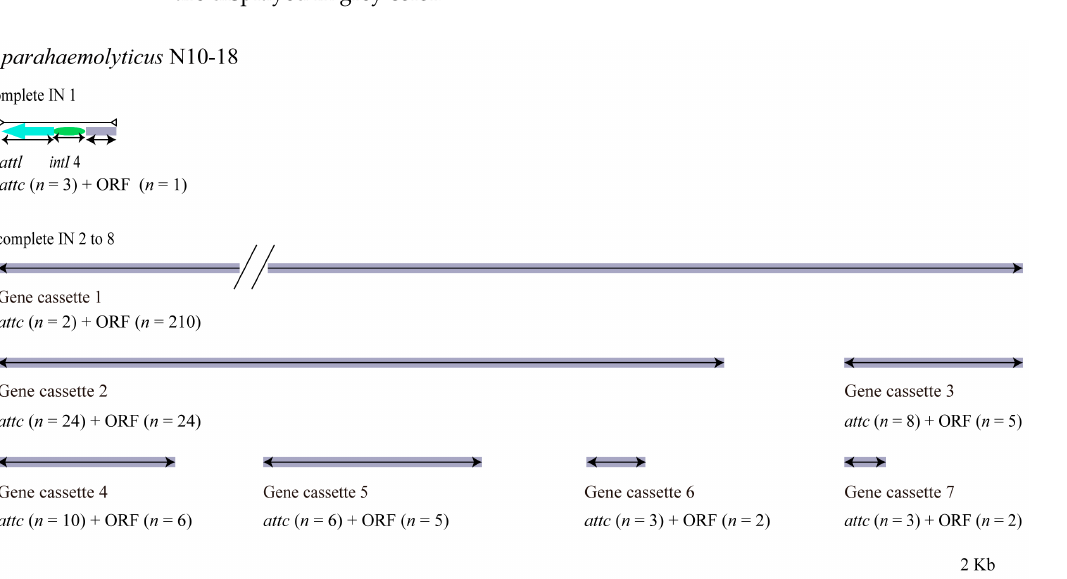
Figure 3. The gene organization of the GIs identified in the V. parahaemolyticus N10-18 genome. Different colors refer to COG classification to mark gene function, and genes with unknown function are displayed in grey color.